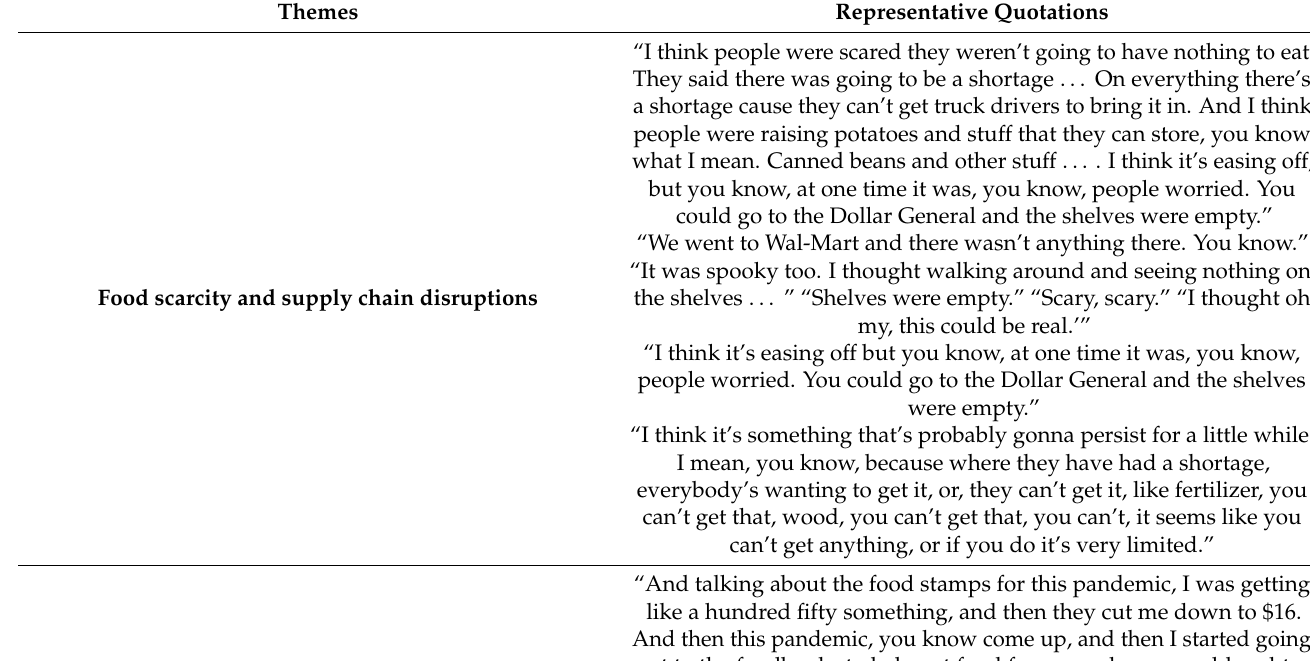
Table 3. Themes and representative quotations from focus groups in Martin County, Kentucky,